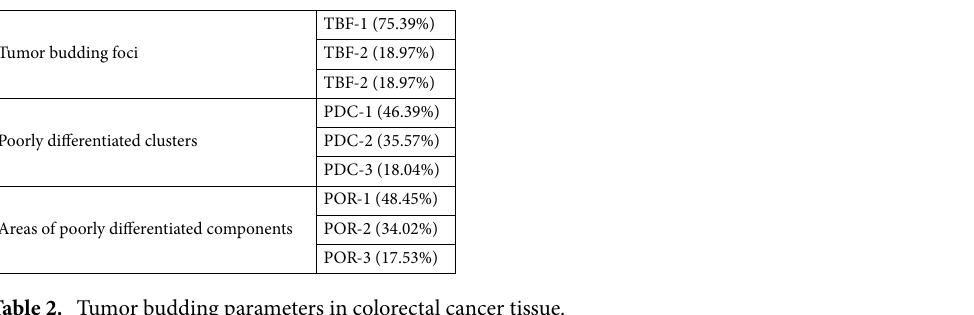
Table 2. Tumor budding parameters in colorectal cancer tissue.